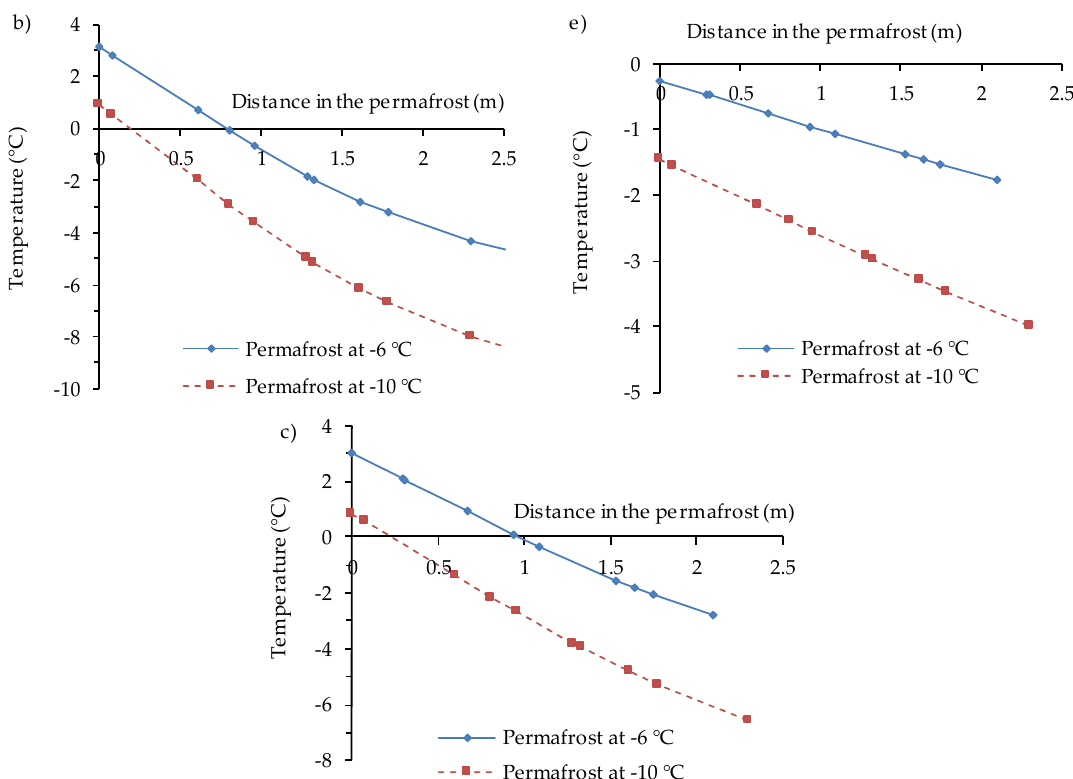
Figure 11. Thickness of thawed permafrost ( T > 0) for a CPB deposition temperature of 14 °C and initial permafrost temperatures of −6 °C and −10 °C after curing times of: ( a ) 7 days, ( b ) 14 days, ( c ) 28 days, ( d ) 120 days, and ( e ) 365 days (distance 0 represents the interface between the CPB and permafrost).